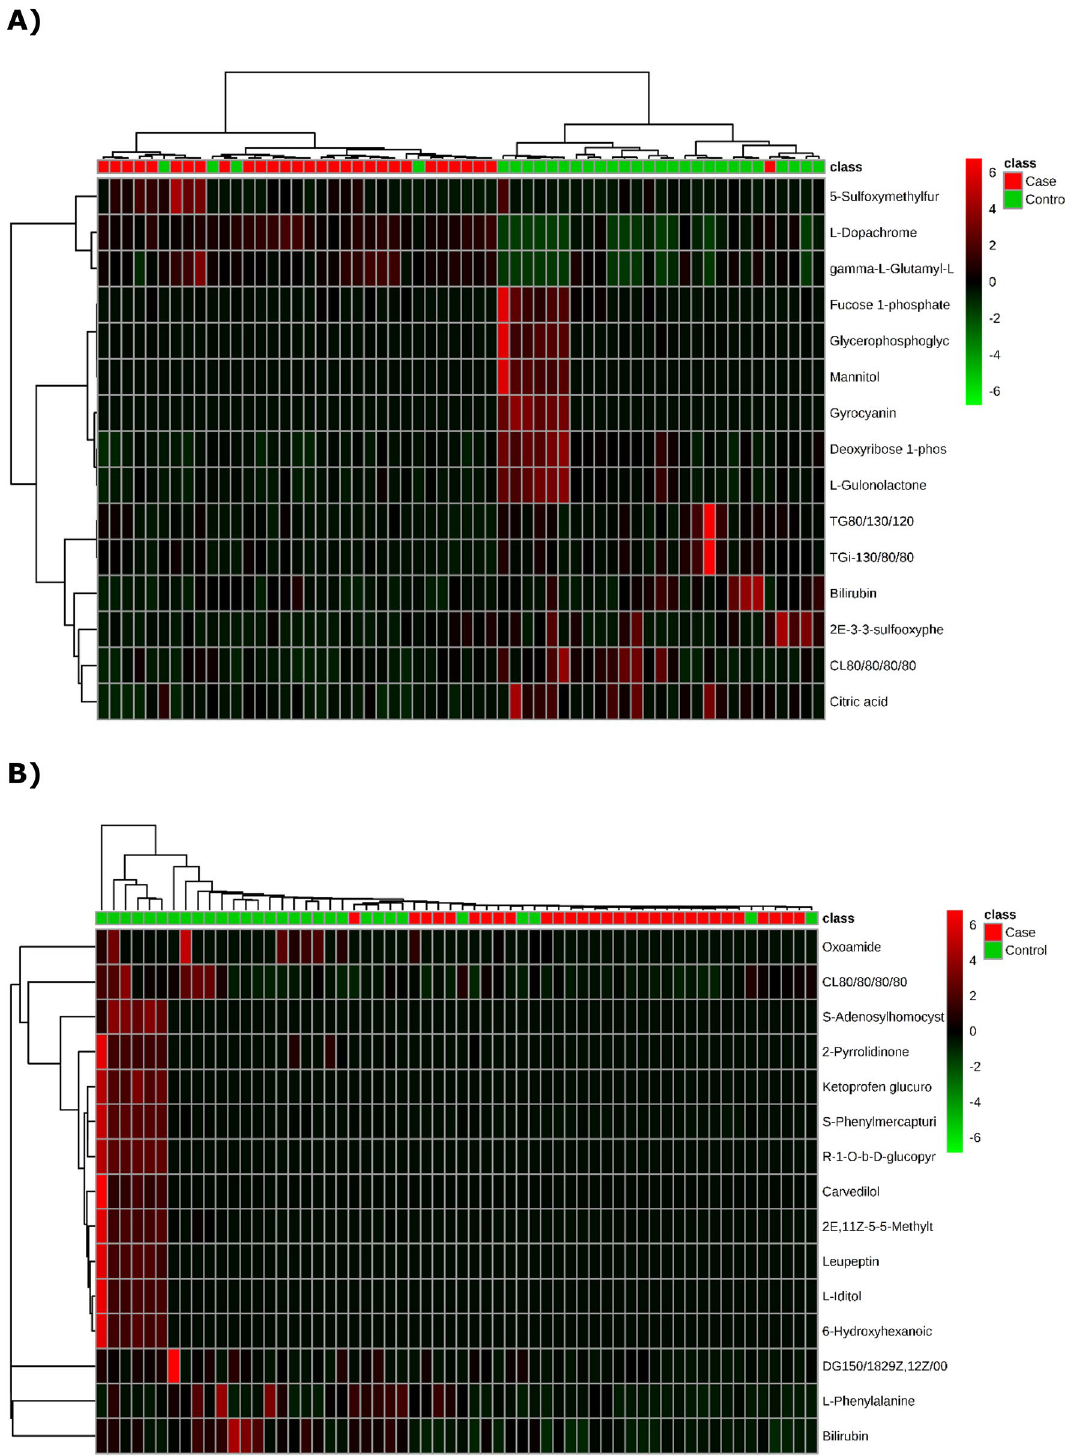
Figure 3. Hierarchical cluster analysis of metabolome data from significant metabolites. ( A ) Negative ion mode ( B ) Positive ion